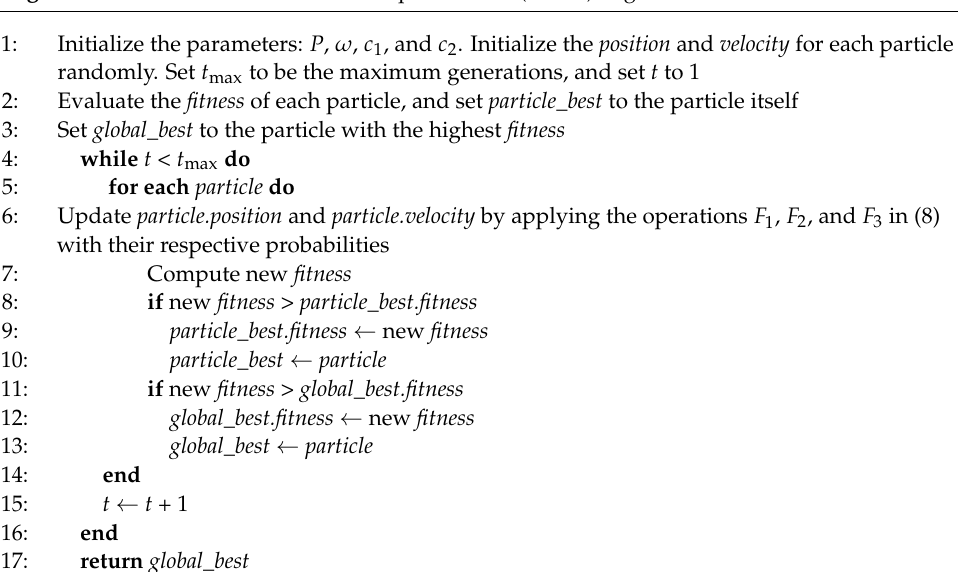
Algorithm 2: Discrete Particle Swarm Optimization (DPSO)